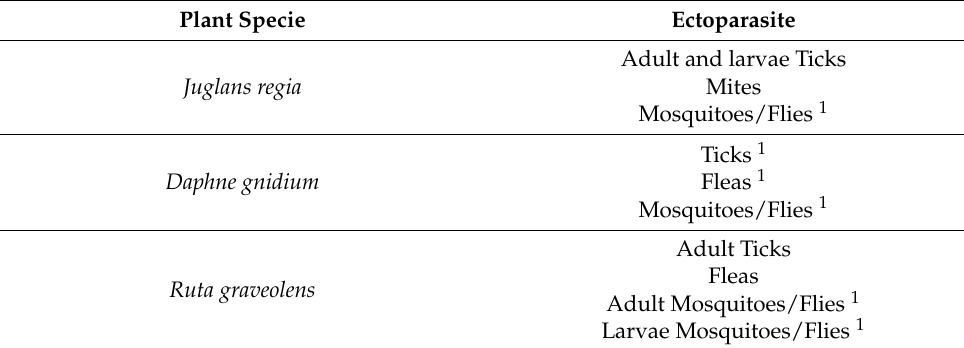
Table 4. Overview of selected plants with ectoparasiticide